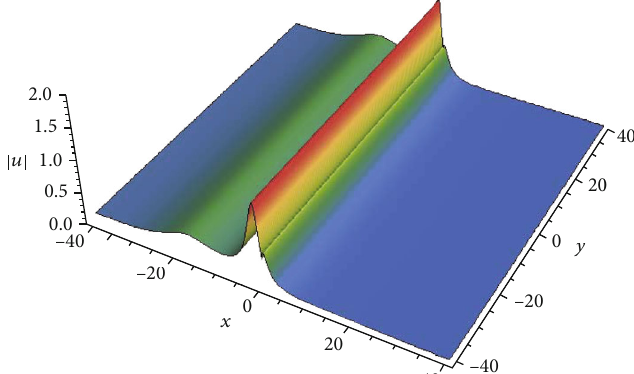
Figure 4: Fractional one-soliton ∣ u ∣ with α = 53/98 by selecting a = 1 , b = 1 : 5 , c = 0 , k